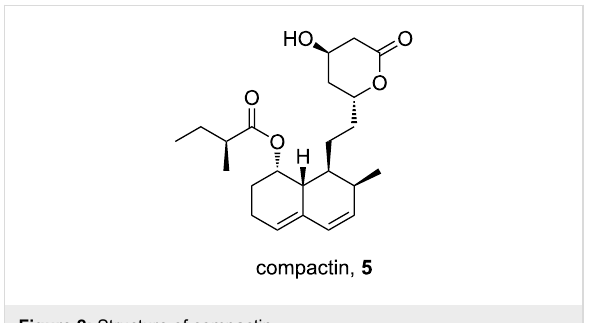
Figure 2: Structure of